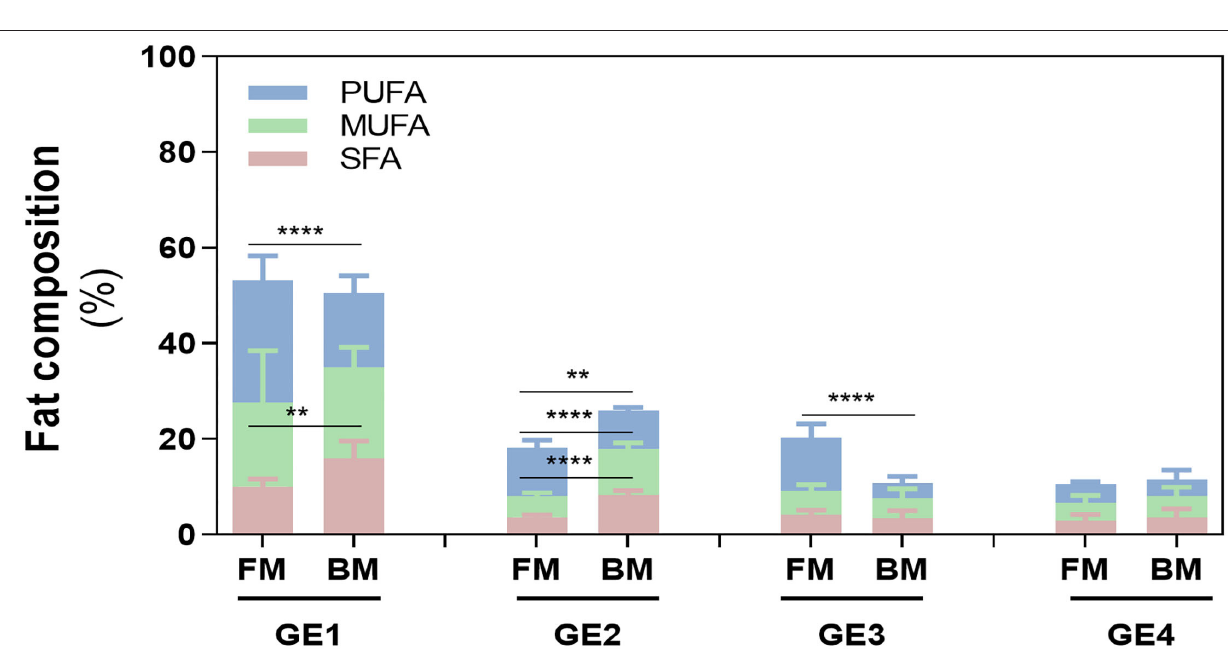
FIGURE 4 | Fatty acid (FA) composition during digestion. Release of FA in each gastric emptying (GE) of beef and fish meal diets. Data are presented as the average ± SD of eight replicates ( n = 8). Parametric ( t -test) statistical tests were applied to compare FA release between beef or fish meals, and statistical differences are indicated as ** p < 0.01 and **** p < 0.0001. GE1 to GE4 mean gastric emptying 1 to gastric emptying 4. FM, fish meal; BM, beef meal; SFA, saturated fatty acids; MUFA, monounsaturated fatty acid; PUFA, polyunsaturated fatty